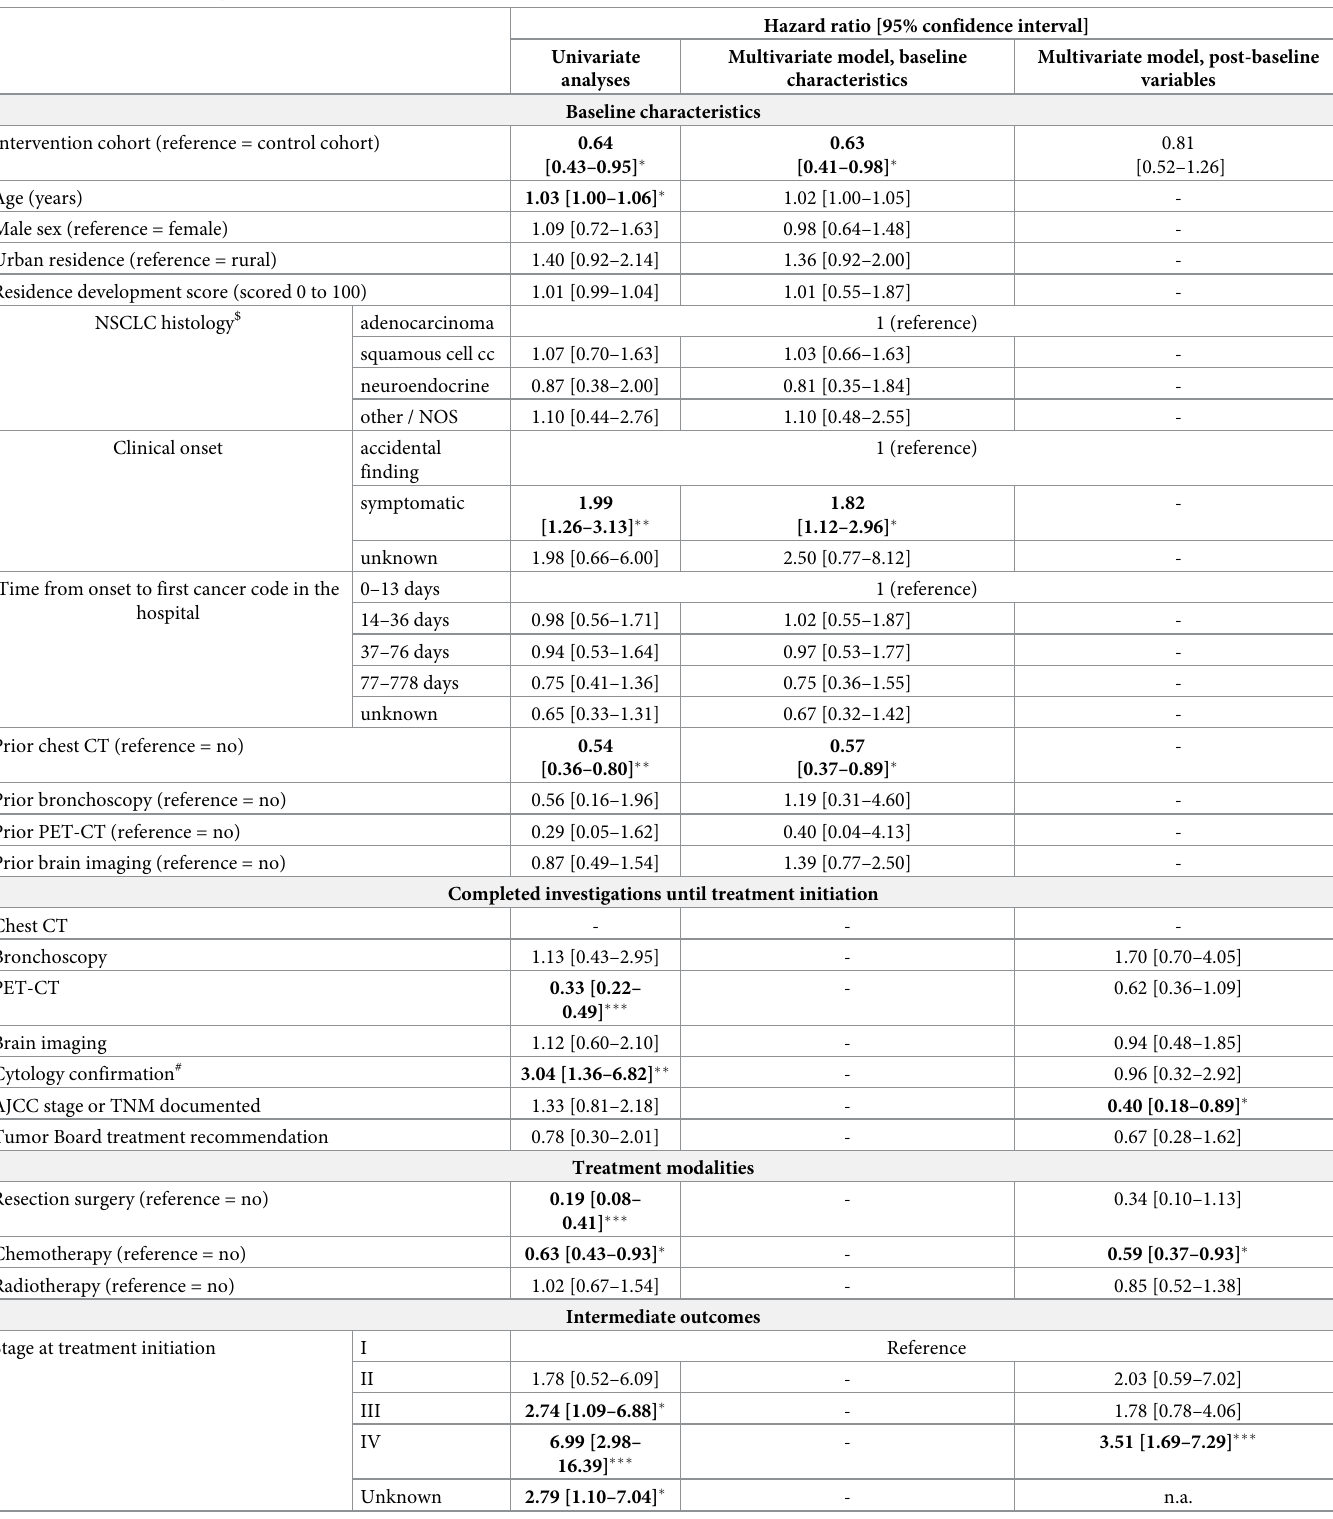
Table 2. Association between mortality and patient characteristics (weighted dataset). Bolded values indicate statistical significance (95%CI not including 1; note that numbers are rounded to 2